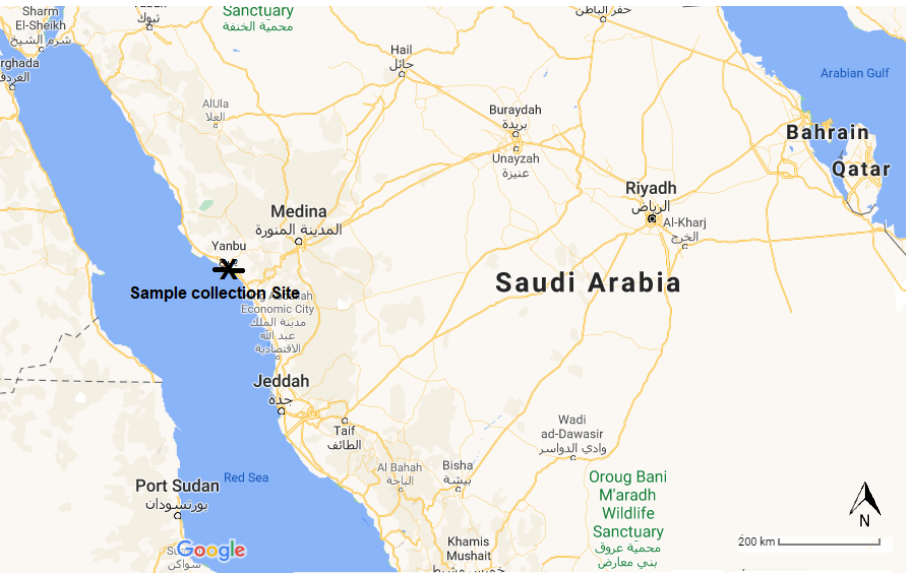
Figure 1. A map presenting the collection site by the Red Sea at the city of Yanbu, Saudi Arabia.